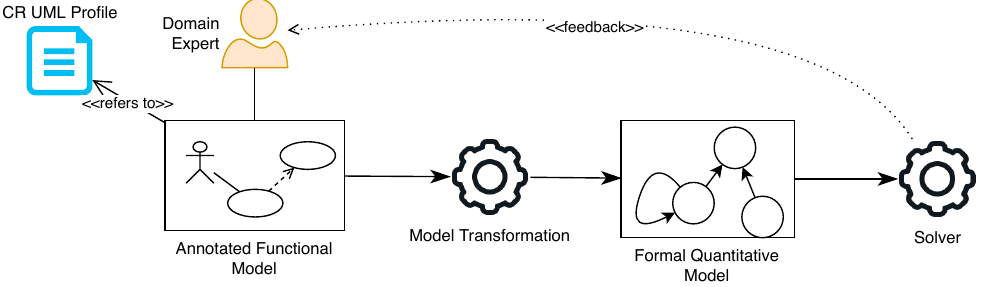
Figure 8. Risk assessment process of cyber-resilient